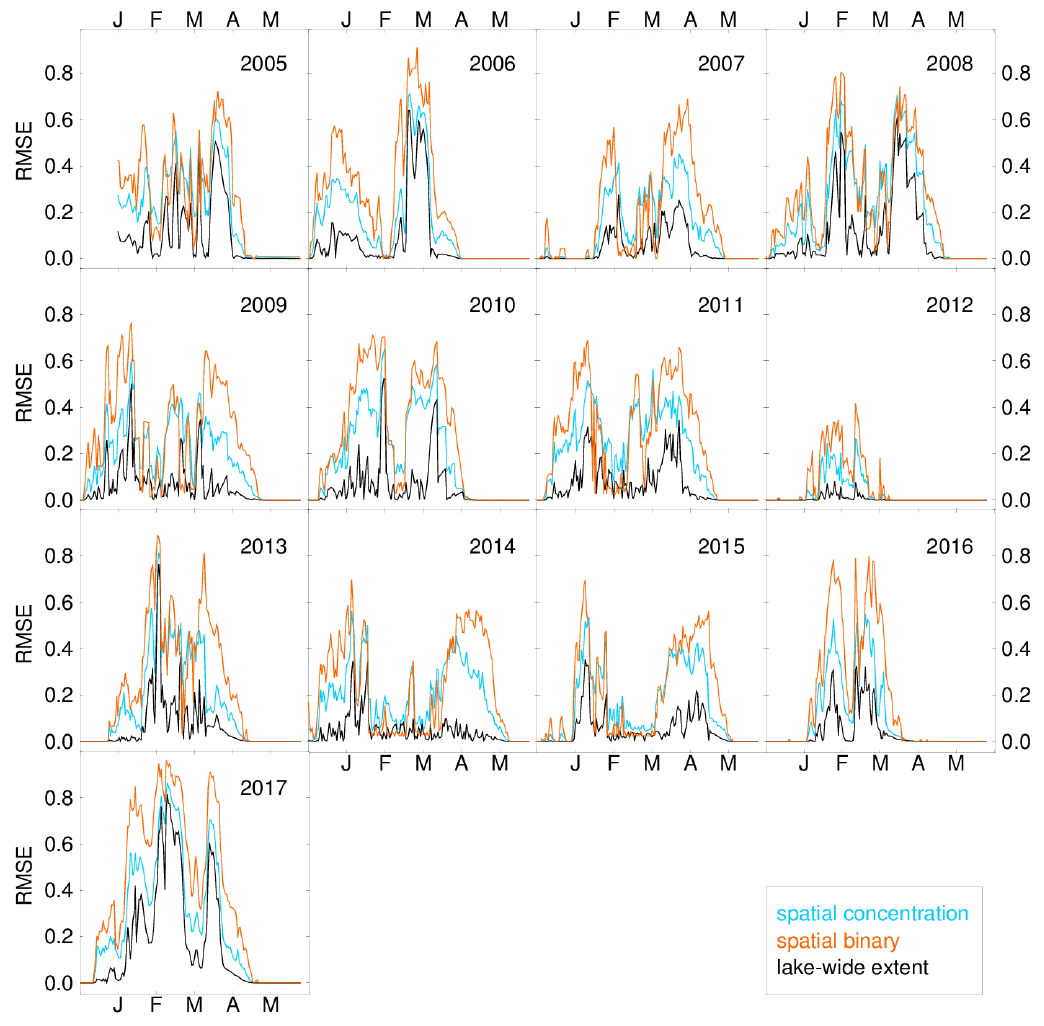
Figure 4. Time series of ice simulation errors between the Lake Erie model and the NIC based on the three methods: Pixel-to-pixel RMSE based on ice concentration ( cyan ), pixel-to-pixel RMSE based on binary ice cover ( orange ), and lake-wide absolute error ( black ). Please note that lake-wide absolute error shows only the magnitude of error (i.e., does not show the sign of model bias).